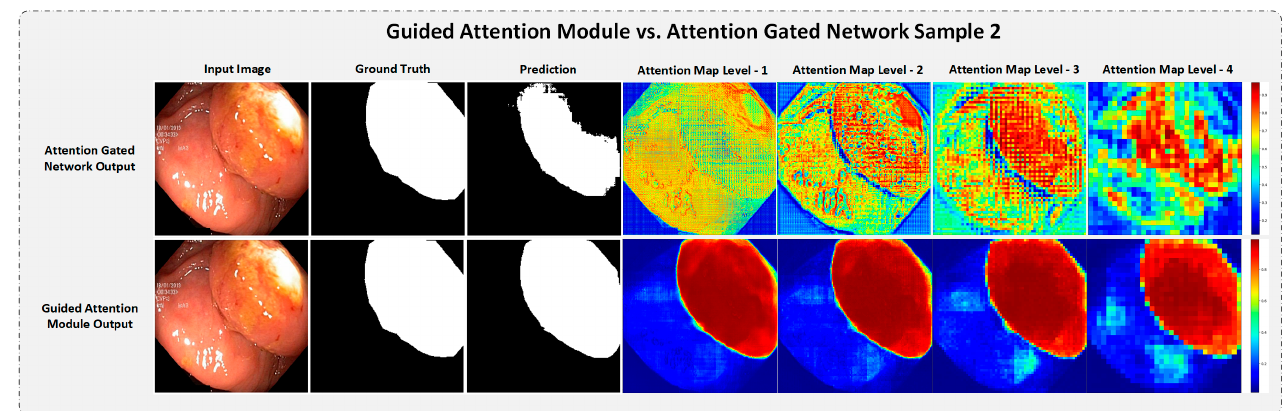
Figure 10. The attention visualization comparison compares Attention Gated Network vs. Guided Attention Module with a test sample from the Kvasir-SEG dataset. Notice even in deeper layers, GAM is still able to capture refined attention maps, while Attention Gated Network-only outputs coarse and broken attention